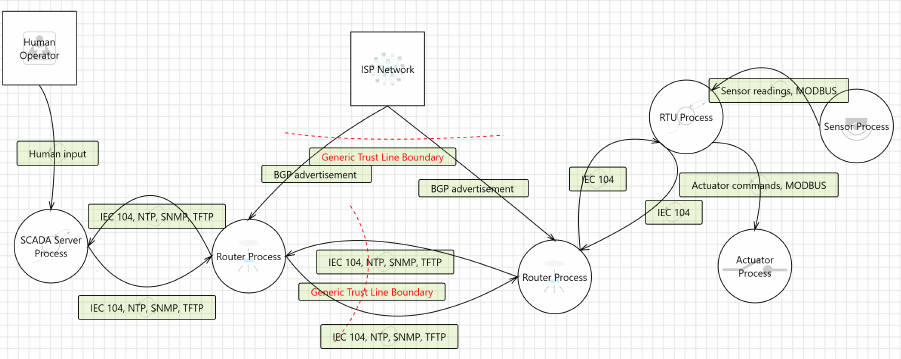
Figure 1. Network-oriented SG-TMT model focusing on remote